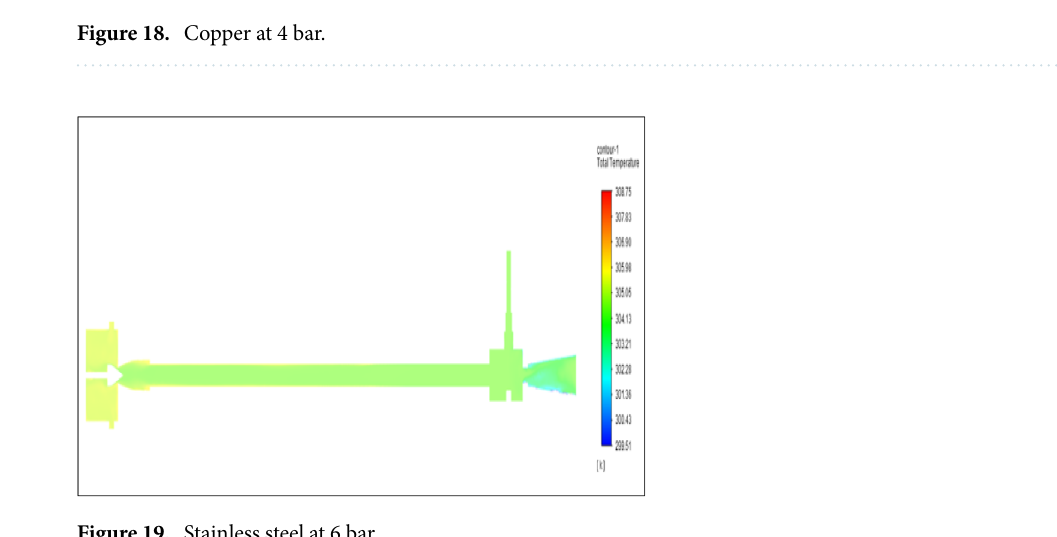
Figure 19. Stainless steel at 6 bar.